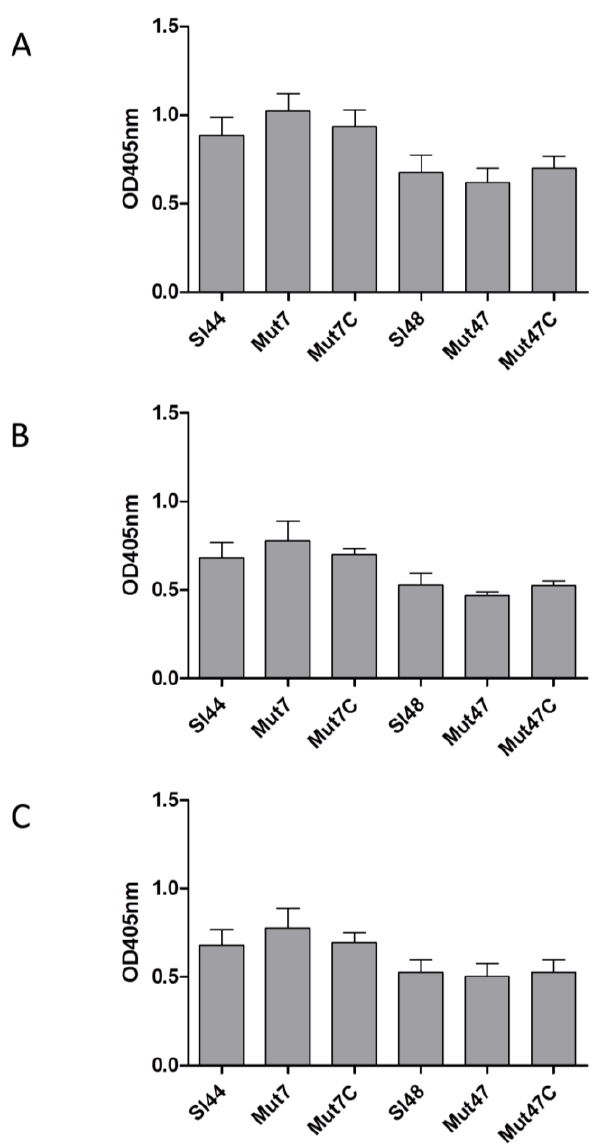
Figure 10. Adherence of S. lugdunensis wild-type (Sl44 and Sl48), ∆ srtA mutant (Mut7 and Mut47) and complemented mutant (Mut7C and Mut47C) strains to immobilized human host cells (( A ): endothelial cell line EA.hy926, ( B ): fetal lung A549 fibroblasts and ( C ): urinary bladder carcinoma cell line 5637 (ATCC HTB-9 ™ )) assessed by ELISA adherence assays. Results are shown as the mean of at three independent experiments with the standard deviation (SD). Statistical analyses were performed using one-way ANOVA with Bonferroni multiple comparisons posttest, but the di ff erences were not